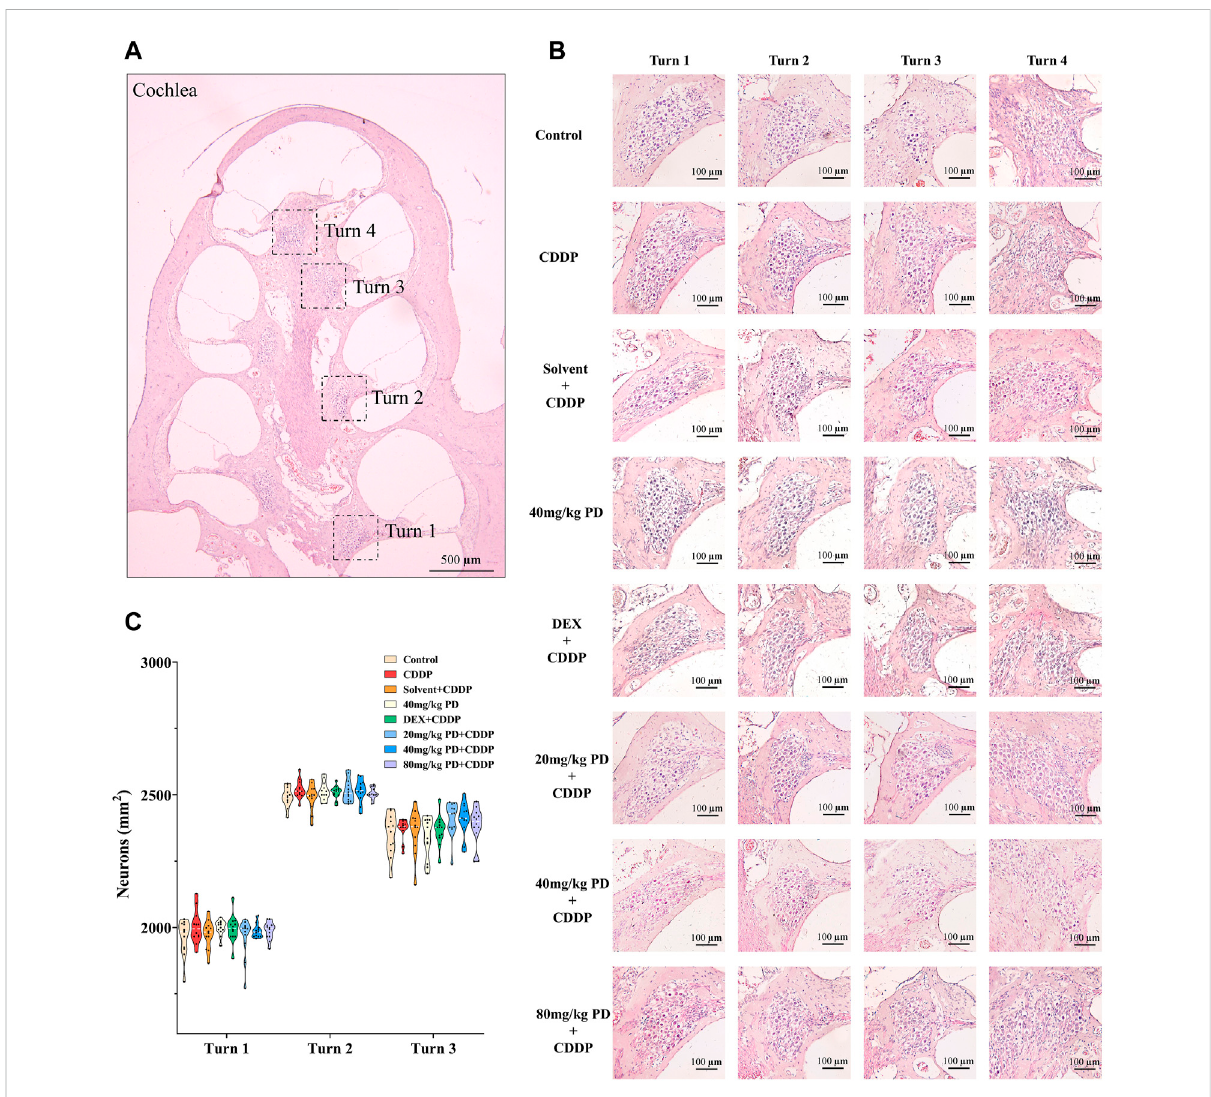
FIGURE 2 There was no signi fi cant loss of SGNs in guinea pig cochlea within 72 h after cisplatin or PD administration. (A) Paraf fi n sections (5 μ m in thickness) were cut parallel to the longitudinal axis of the cochlea and then H&E staining was performed. According to the results, the cochlea of guinea pigs could be divided into turn 1, turn 2, turn 3, and turn 4. Scale bar, 500 μ m. (B) In each group, SGNsin turn 1,turn 2 and turn 3were closely distributedandnoobviouslosswasobserved.Scalebar,100 μ m. (C) GraphshowsthenumberofSGNsinthefullRosenthal ’ sinturn1,turn2and turn3 in each group, n = 4. Data are presented as mean ±